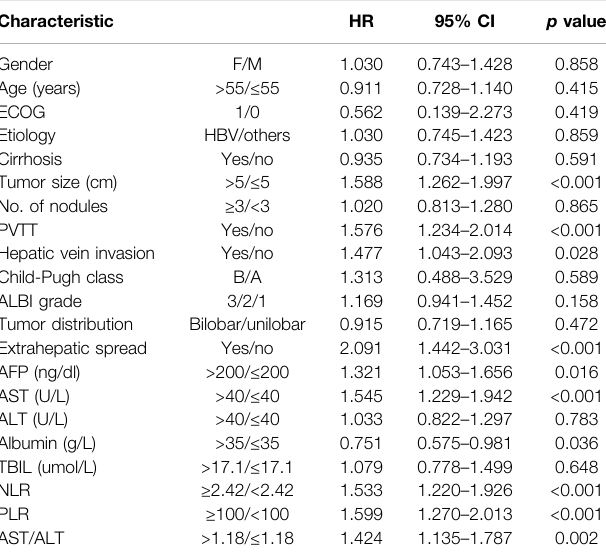
TABLE 4 | Univariate analysis of risk factors associated with progression-free survival. Characteristic